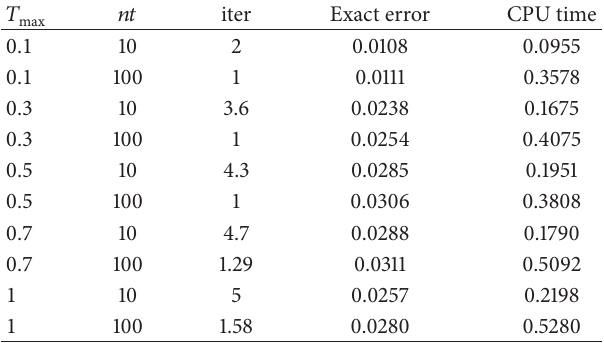
Table 4: Numerical results for CCGT2 and different values of 𝑇 max .